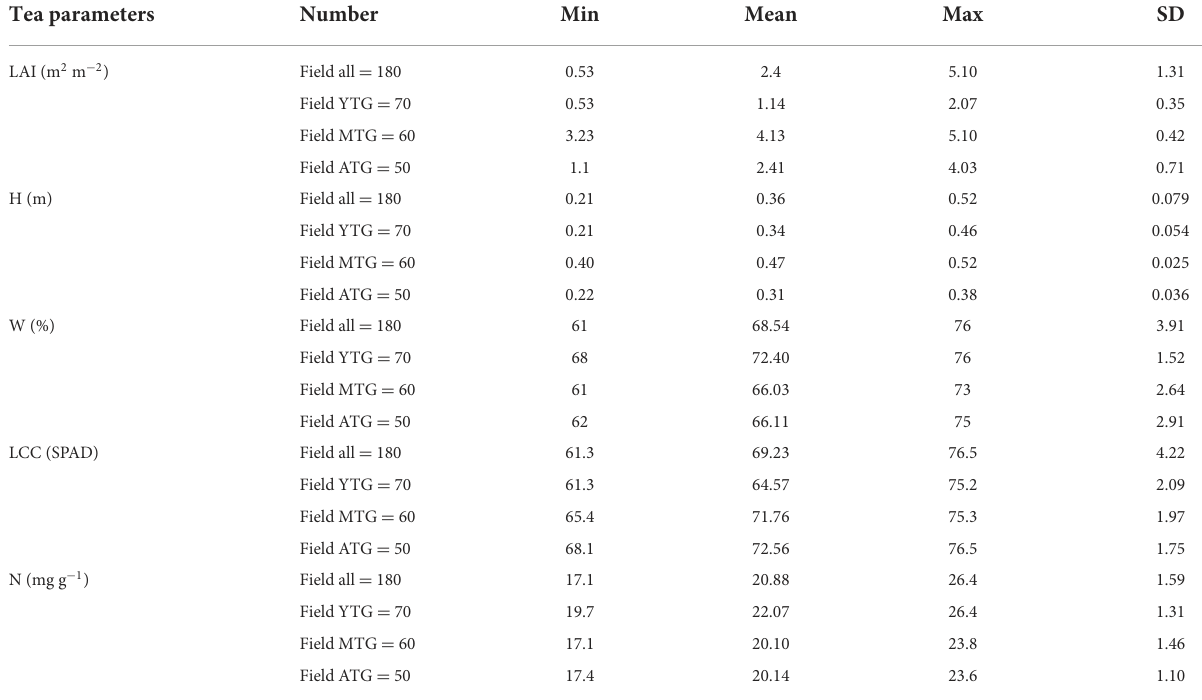
TABLE 2 Descriptive statistics were used to analyze the phenotypic parameters of tea plantations. Tea